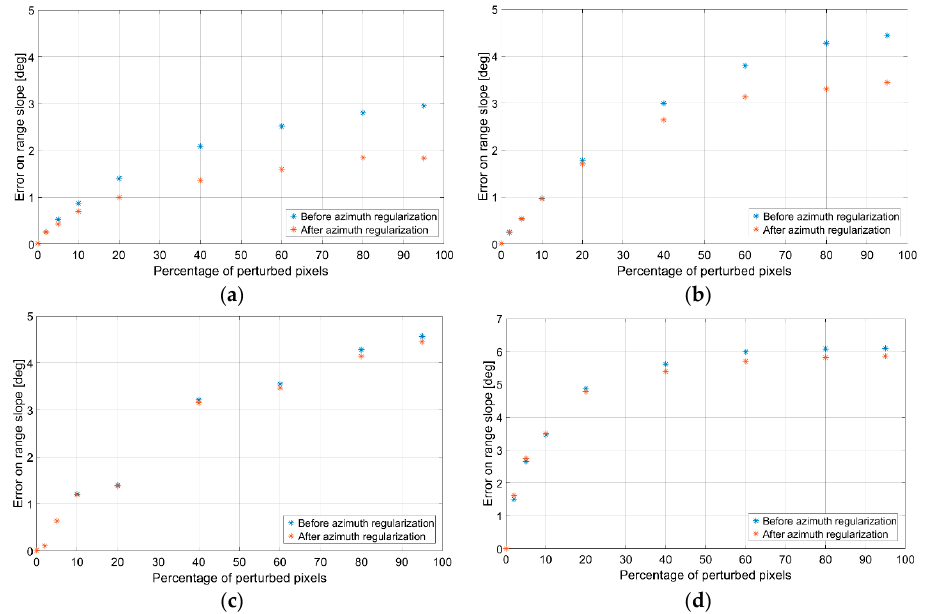
Figure 3. Evaluation of range slope error behavior due to electromagnetic (case 1) ( a – c ) and roughness (case 2) ( d ) non-homogeneity over the scene as a function of the percentage r of pixels affected by variations. Non-homogeneity affects ( a ) single pixels, ( b – d ) 20 × 20 patches, ( c ) 200 × 200 patches.